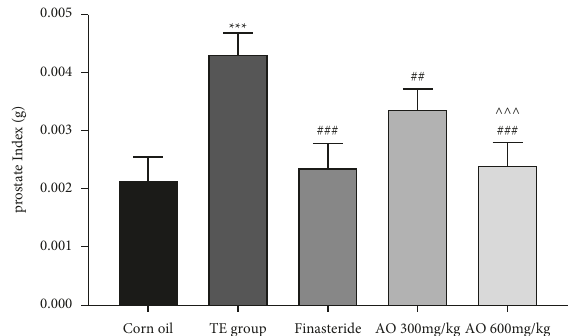
Figure 2: Prostate index of groups; normal control (corn oil), disease (testosterone group), finasteride, and extract with 300 and 600mg/kg (AO) groups. Group 1 (normal group), group 2 (disease group), group 3 (standard medicine group), and groups 4 and 5 treated with 300mg/kg and 600mg/kg AO extract for 28 days. The values are expressed as mean ± SEM ( N � 6 animals/group). ∗ − p < 0 . 05, ∗∗ − p < 0 . 01, and ∗∗∗ − p < 0 . 001 vs. control, and # p < 0 . 05, ## p < 0 . 01, and ### p < 0 . 001 vs. TE group.